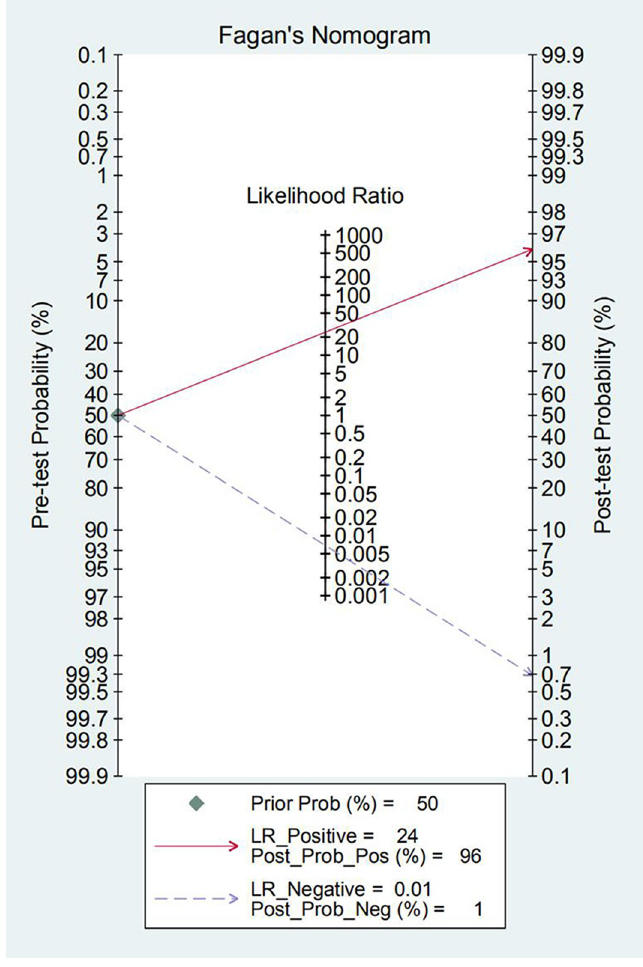
Fig 6. Fagan’s nomogram plot analysis for evaluating clinical application